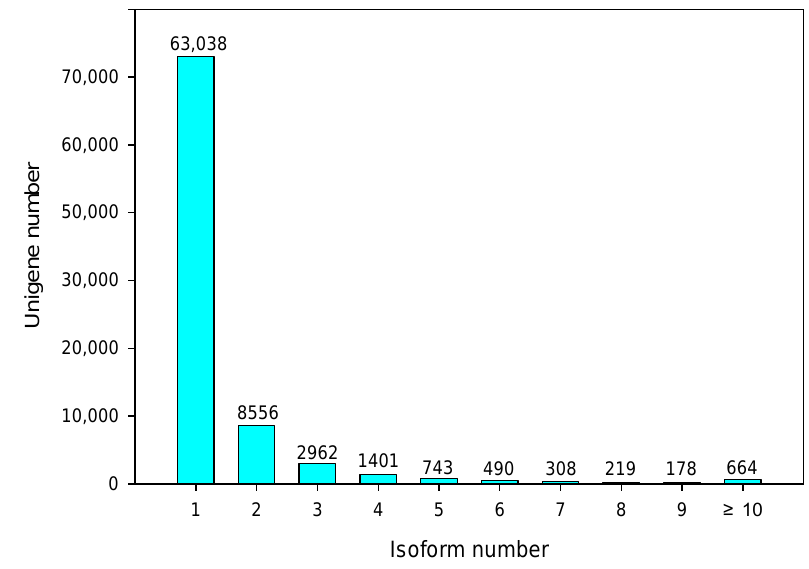
Figure 2. Number of isoforms in purslane ( Portulaca oleracea ).